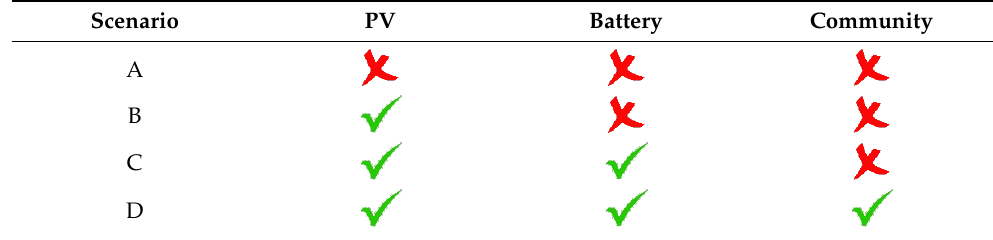
Table 2. Definition of the analysed scenarios.